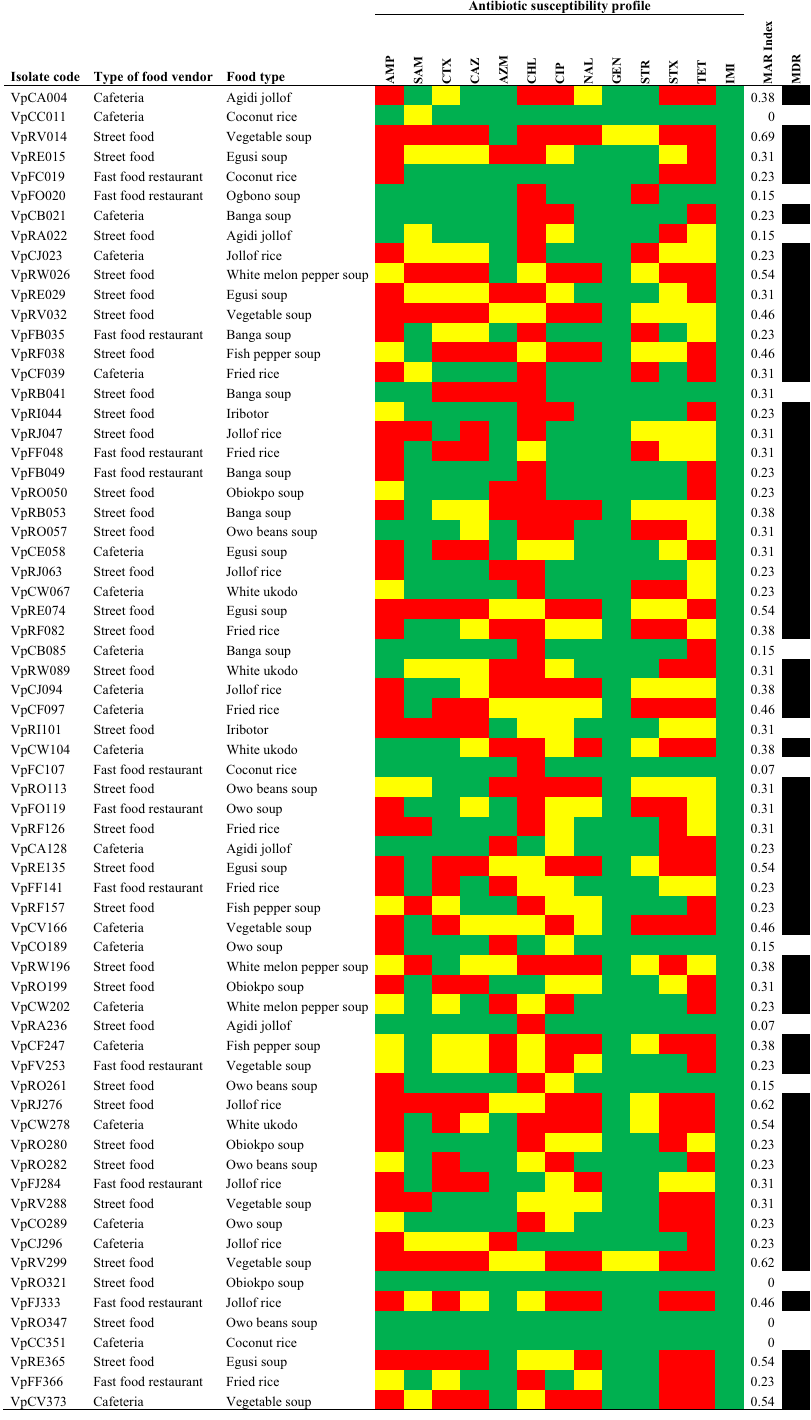
Table 2. Distribution profile of V. parahaemolyticus antibiotic susceptibility. Red filled square = resistance, green filled square = sensitive, yellow filled square = intermediate, black filled square = positive, white filled square = negative. MDR multidrug resistance, MAR multiple antibiotic resistance, AMP ampicillin, CAZ ceftazidime, CTX cefotaxime, SAM ampicillin/sulbactam, AZM azithromycin, CIP ciprofloxacin, CHL chloramphenicol, STR streptomycin, NAL nalidixic acid, STX trimethoprim-sulfamethoxazole, TET tetracycline, IMI imipenem, GEN